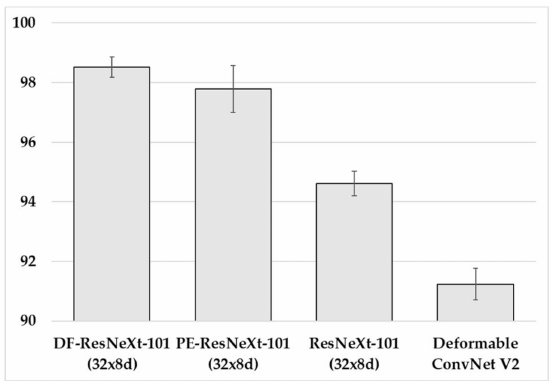
Figure 10. Mean accuracy with standard deviation error bar.